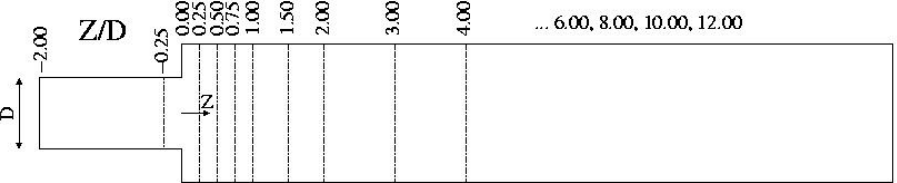
Figure 7. Measurement cross-sections. Numbers refer to Z/D, where D is the inlet diameter, and Z = 0 at the abrupt expansion.